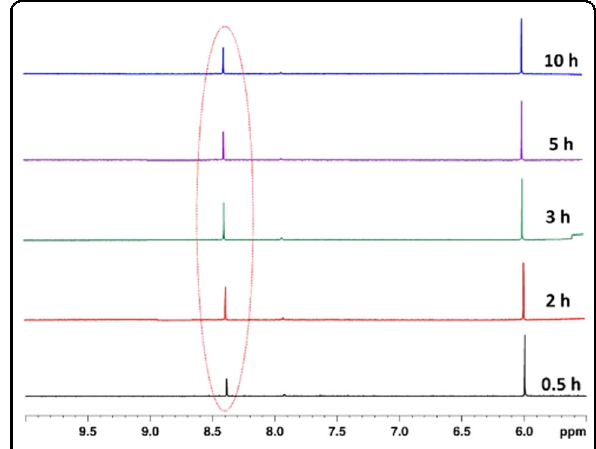
Fig. 5 Identi fi cation of electrochemical products. H-NMR spectra of electrolyte solutions sampled after different experimental times at a constant potential of − 0.3 V vs. RHE (10% D 2 O was added to all samples and maleic acid was used as an internal